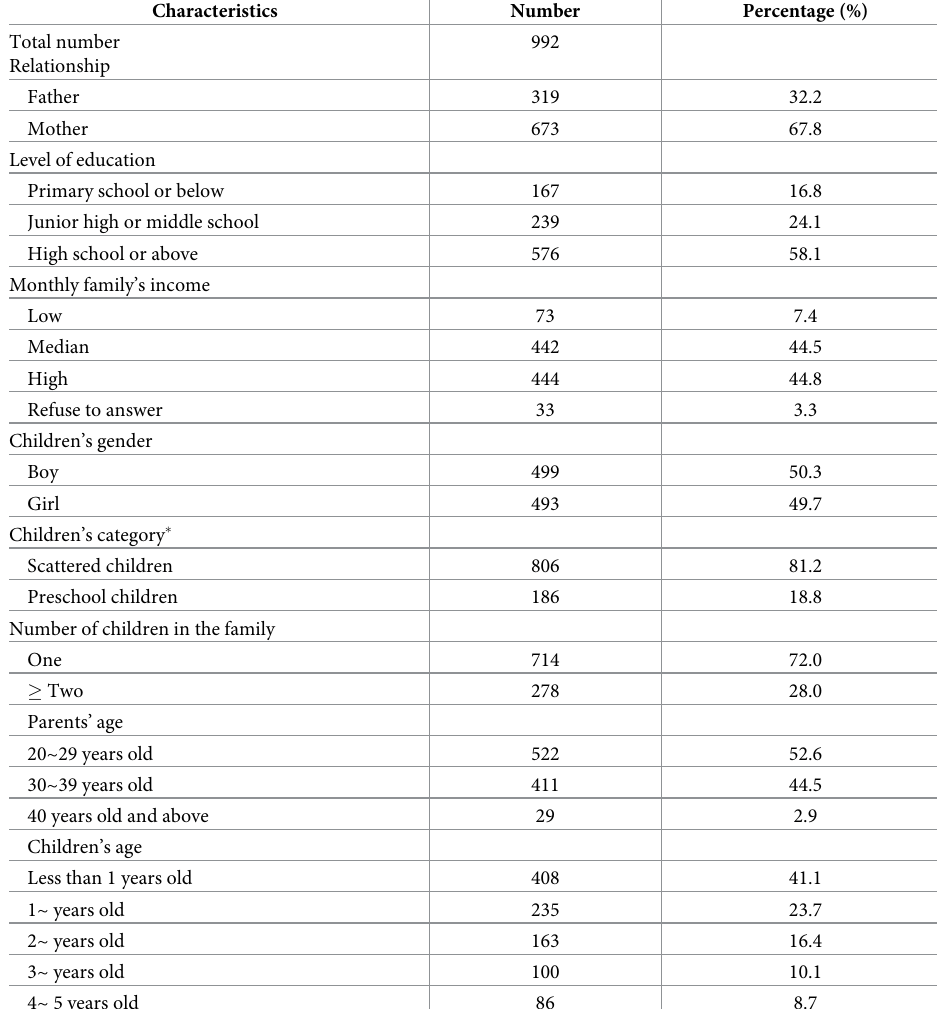
Table 1. Demographic characteristics of participants in the study of knowledge of HFMD and acceptability of EV71 vaccine among parents of under-five in Chongqing, China.